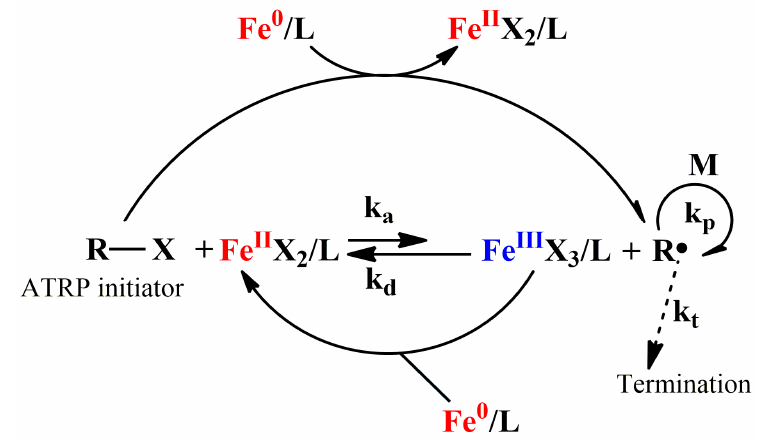
Figure 6. Mechanism of SARA ATRP catalyzed Fe(0) catalyst.